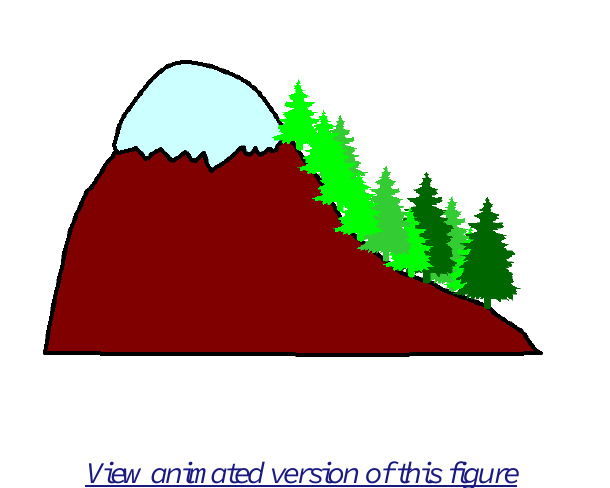
Fig. 4. A simple depiction of limitation at an ice- forest boundary. At the time scale of interest, the boundaries of each system simply move back and forth with no evidence of